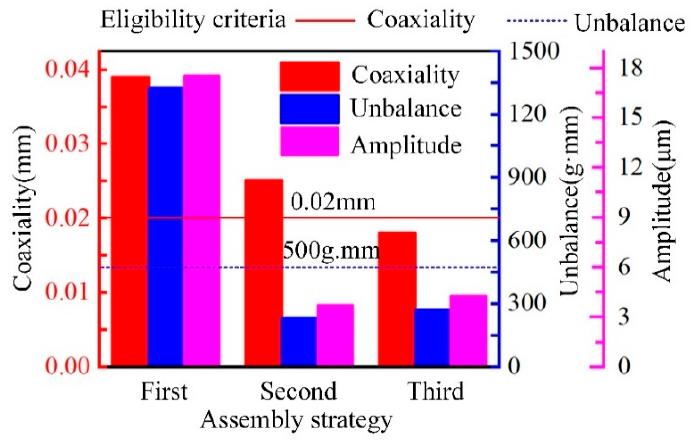
Figure 4. Comparison of vibration amplitude under three assembly models.